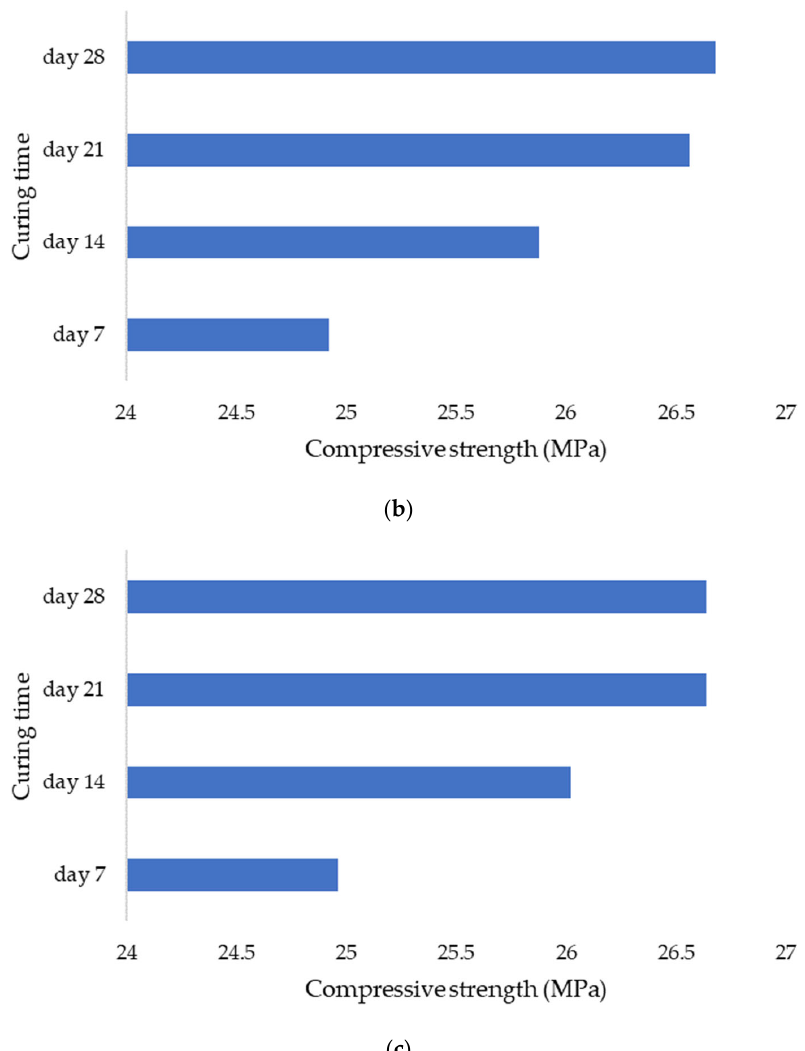
Figure 9. Concrete density monitoring results ( a ) pH = 7 ( b ) pH = 4 ( c ) pH = 12.